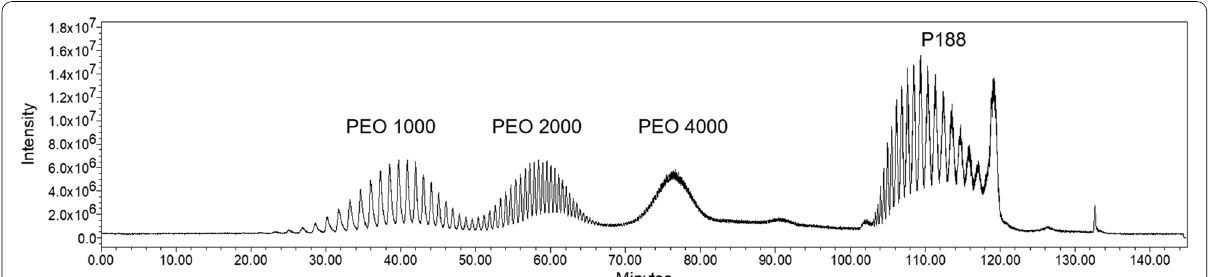
Fig. 1 The chromatogram of a mixture of PEO 1000, 2000, 4000, and P188 measured through the selected ion monitoring liquid chromatography-mass